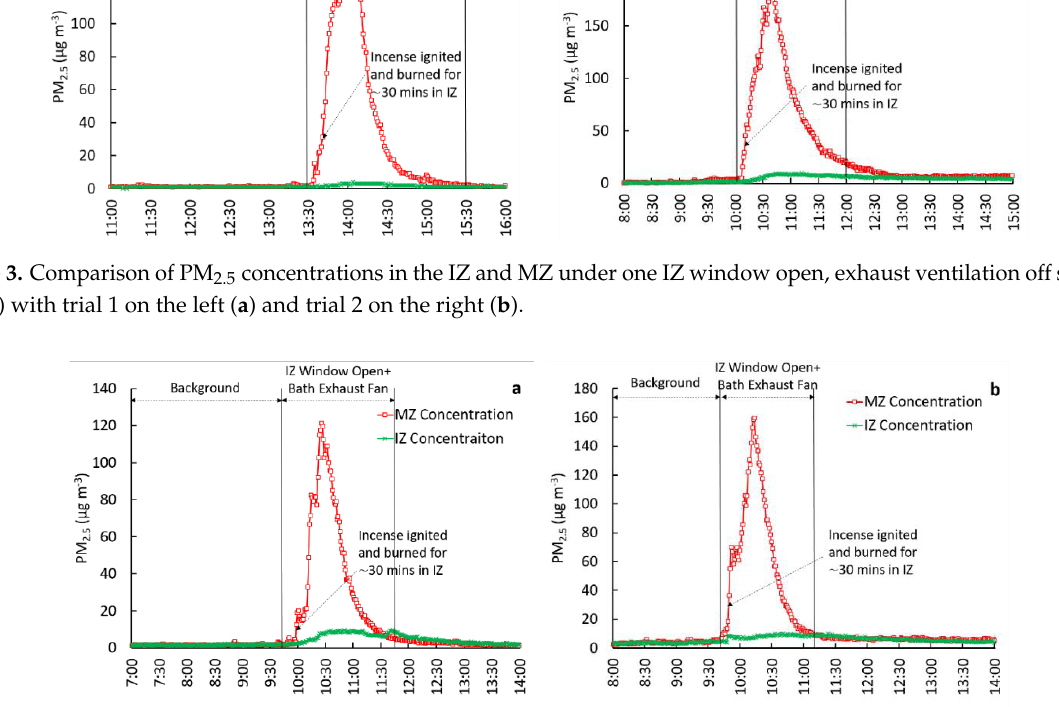
Figure 4. Comparison of PM 2.5 concentrations in the IZ and MZ under one IZ window open, exhaust ventilation on scenario (Test 4) with trial 1 on the left ( a ) and trial 2 on the right ( b ). a : explanation; (Test 4) with trial 1 on the left ( a ) and trial 2 on the right ( b b : explanation.